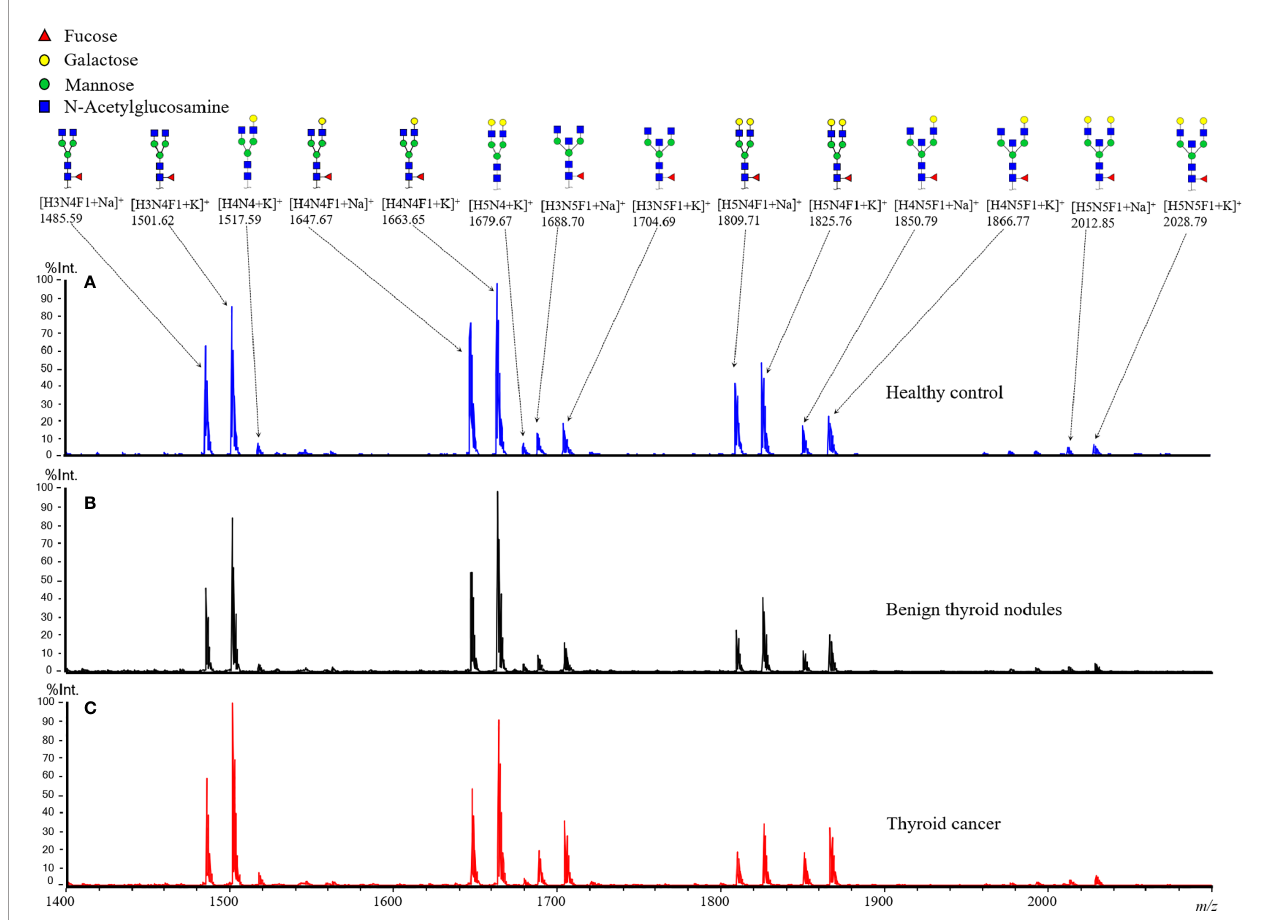
FIGURE 1 | Representative MALDI-TOF MS spectra of plasma IgG N-glycan pro fi les for (A) healthy control, patients (B) with benign thyroid nodules, and (C) with thyroid cancer. Spectra were recorded in positive ion re fl ectron mode on a rapi fl eX MALDI-TOF mass spectrometer with a Smartbeam 3D laser. Major glycan peaks were annotated and assigned to compositions and structural schemes. H, hexose; N, N-acetylhexosamine; F, deoxyhexose